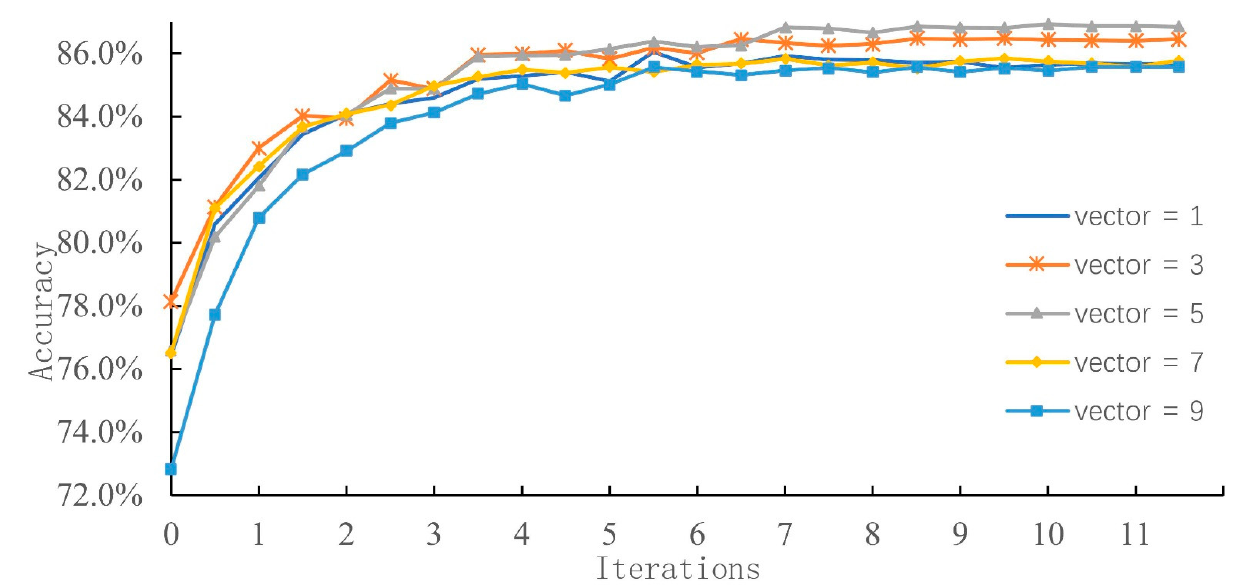
Figure 7. Accuracy of different semantic levels on SNLI dataset.